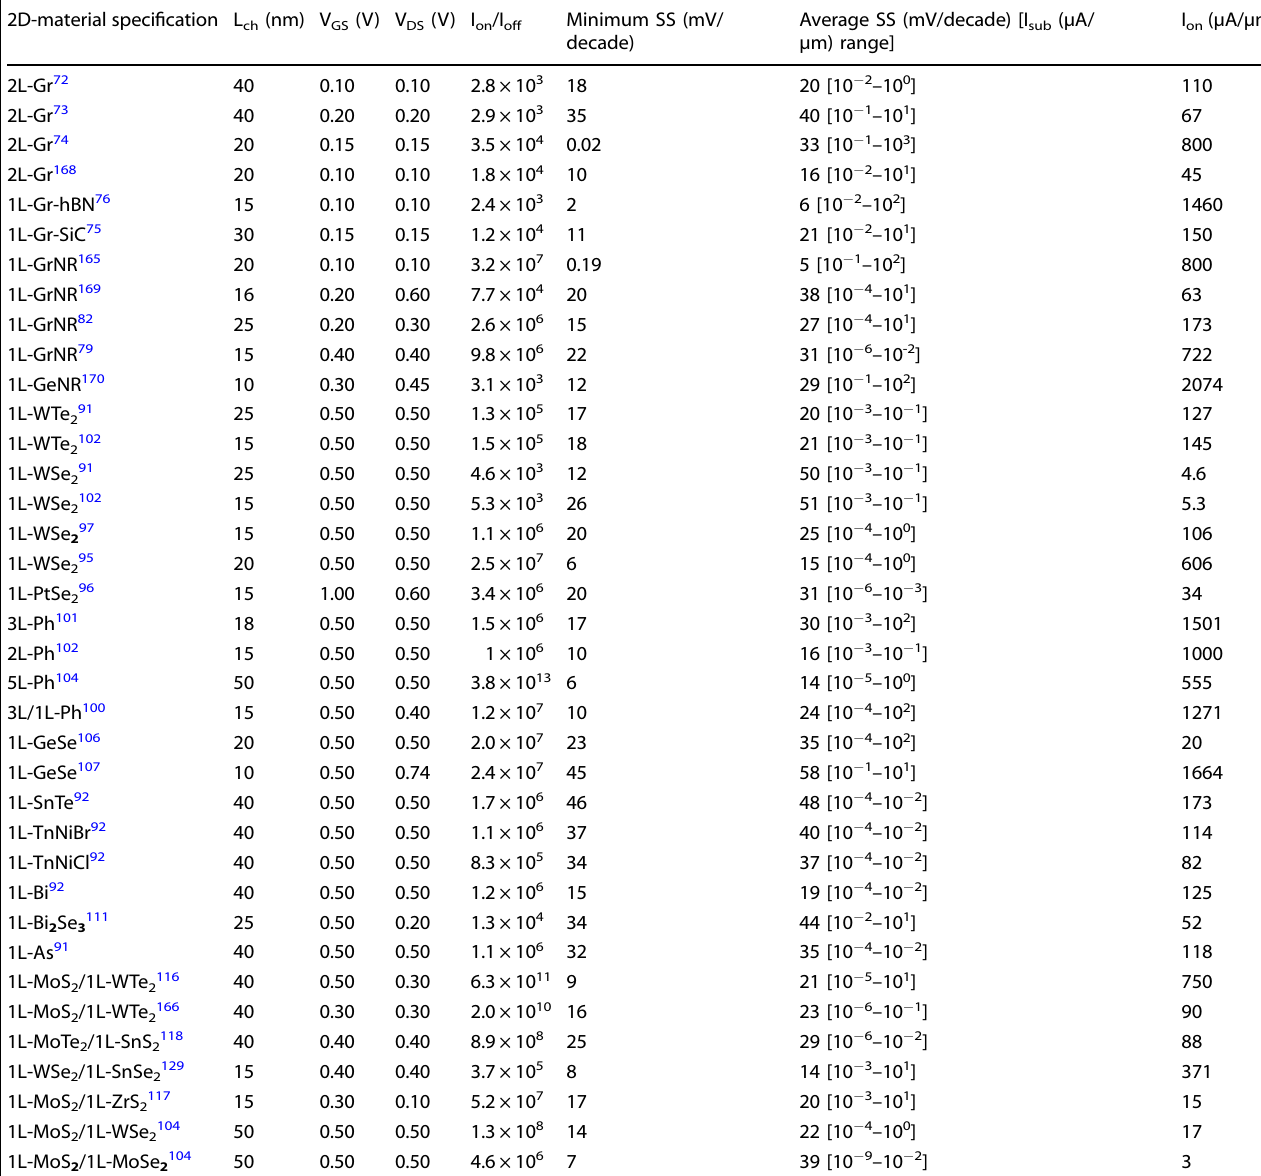
Table 1. Device speci fi cation and performance of different numerical device simulations based reported